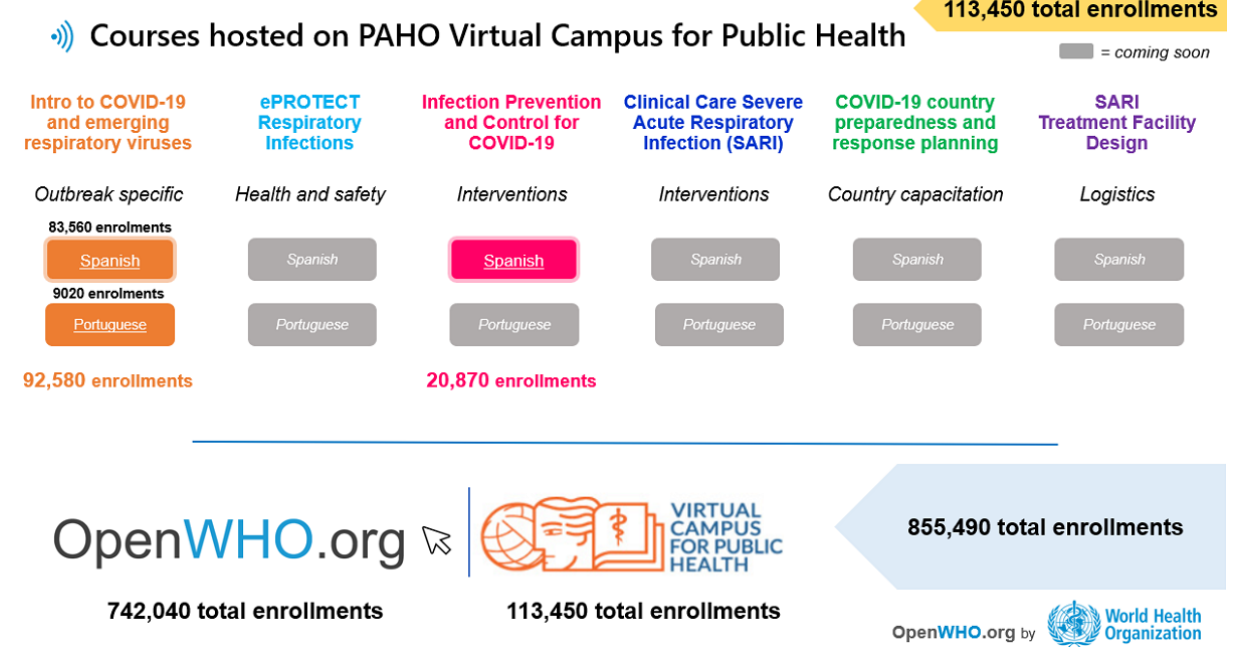
Figure 4. OpenWHO courses hosted on the Pan-American Health Organization virtual campus as of March 27, 2020. COVID-19: coronavirus